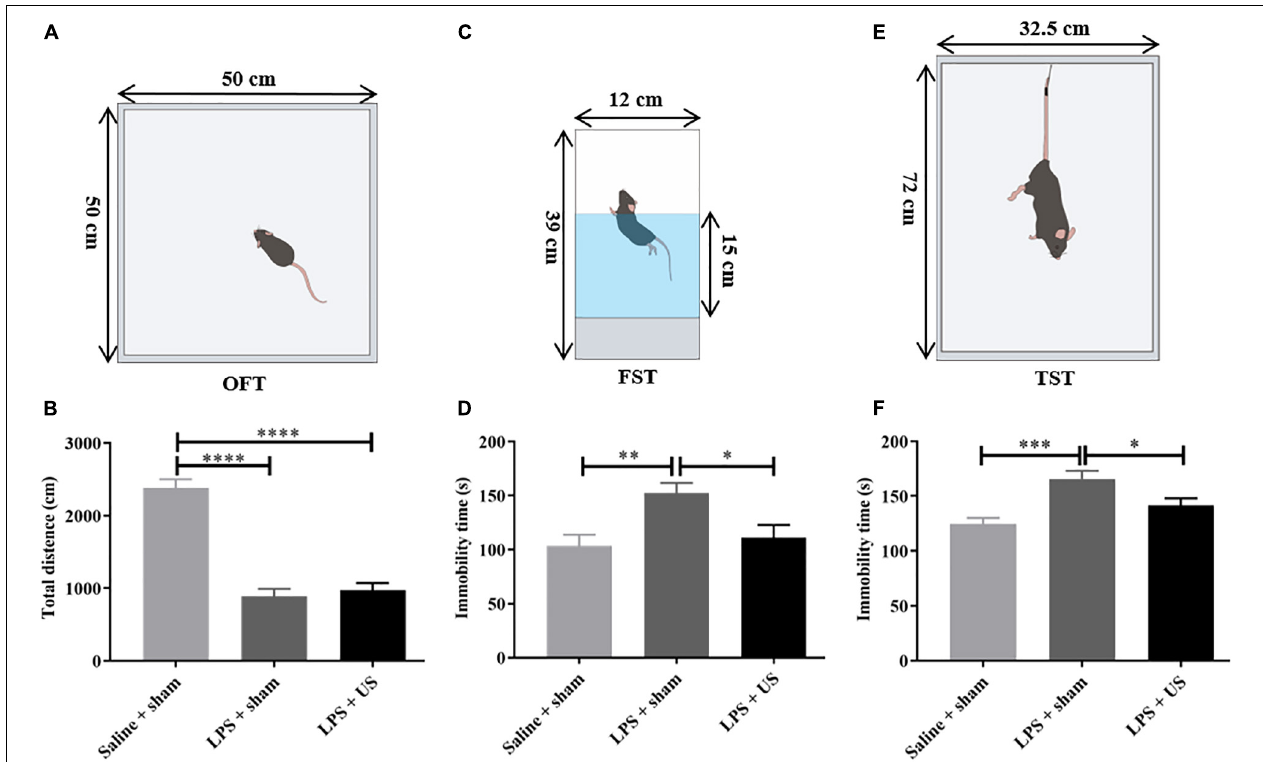
FIGURE 4 | Effect of LPS and US on the behavior of healthy and depressed mice. (A) Schematic diagram of the OFT. (B) The total distance traveled in 5 min is significantly decreased in LPS-treated mice compared with mice injected saline. Schematic diagrams of the FST (C) and TST (E) . After US treatment, immobility time in the FST (D) and TST (F) is significantly reduced 24 h after LPS injection. LPS, lipopolysaccharide; US, ultrasound stimulation; PFC, prefrontal cortex; OFT, open field test; FST, forced swimming test; TST, tail suspension test. * p < 0.05; ** p < 0.01; *** p < 0.001; **** p <